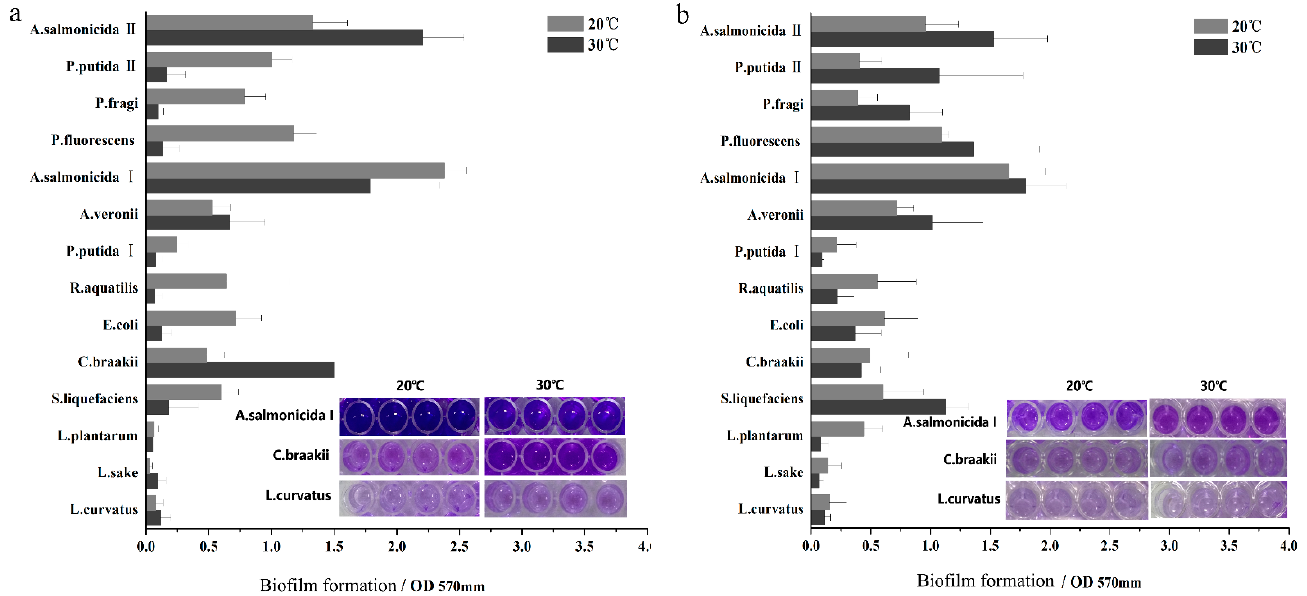
Figure 1. Biofilm formation by 14 selected isolates on 96-well polystyrene microplates under 20 or 30 °C for 24 h ( a ) and 72 h ( b ). Error bars represent standard deviations of the mean ( n = 5). Images of the stained microplates of A. salmonicida I, C. braakii and L. curvatus are shown as representatives.